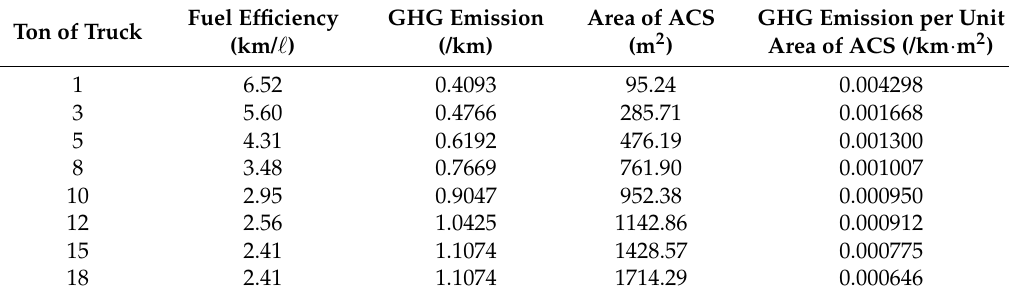
Table 9. GHG emission of fuel-driven equipment (unit: kgCO 2